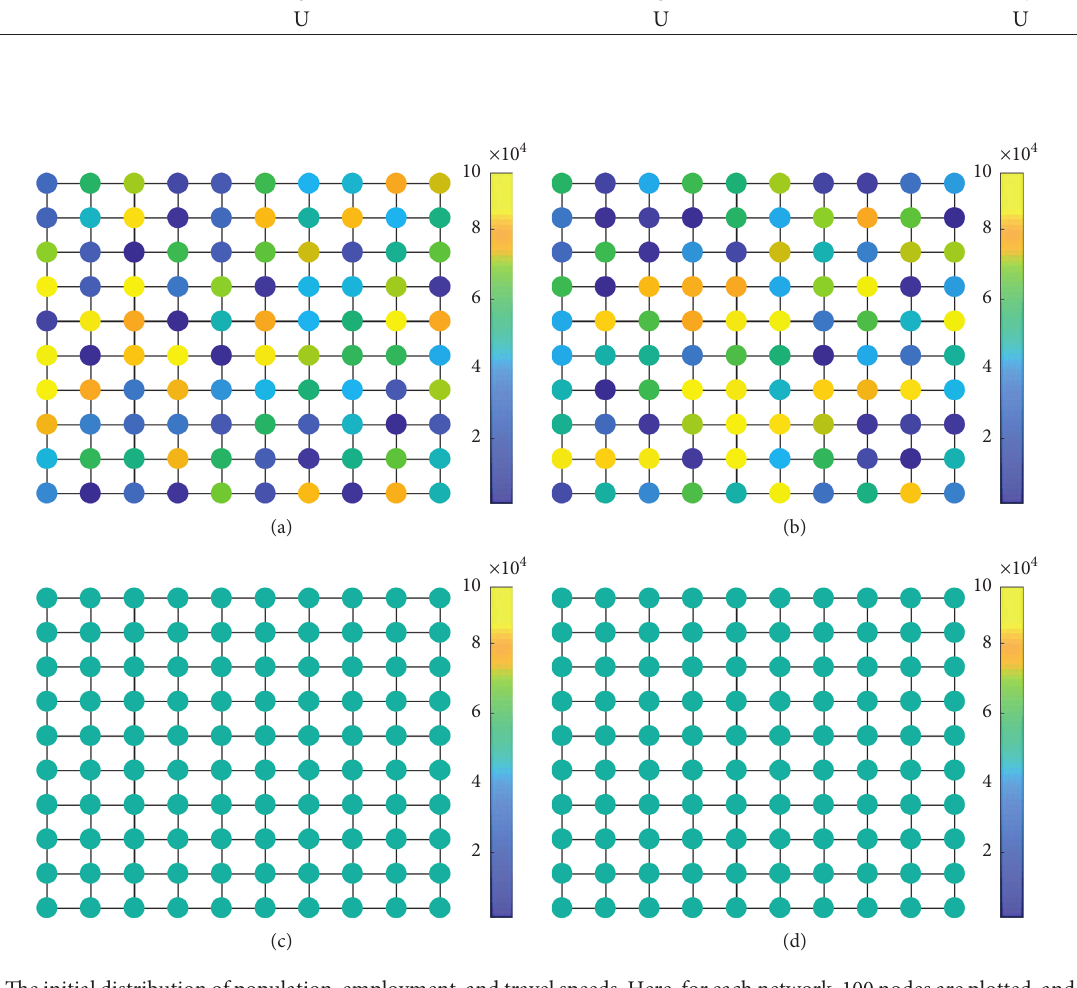
Figure 5: The initial distribution of population, employment, and travel speeds. Here, for each network, 100 nodes are plotted, and the black edges here stand for the travel speeds. (a) The population, employment, and travel speeds are randomly distributed. (b) The population and employment are randomly distributed, but the travel speeds are unified. (c) The population and employment are unified, but the travel speeds are randomly distributed. (d) All of them are uniformly distributed. The colour bar stands for the population amount, the colour of each node can stand for the population and employment amount, and the same is true for the multilayer network